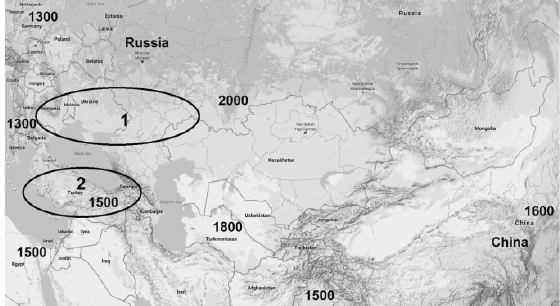
Fig. 1. Map showing “Country of cities” (territories with a diameter of approximately 350-500 km around the number 2000 in the center) and the chariot spread: 2000–1300